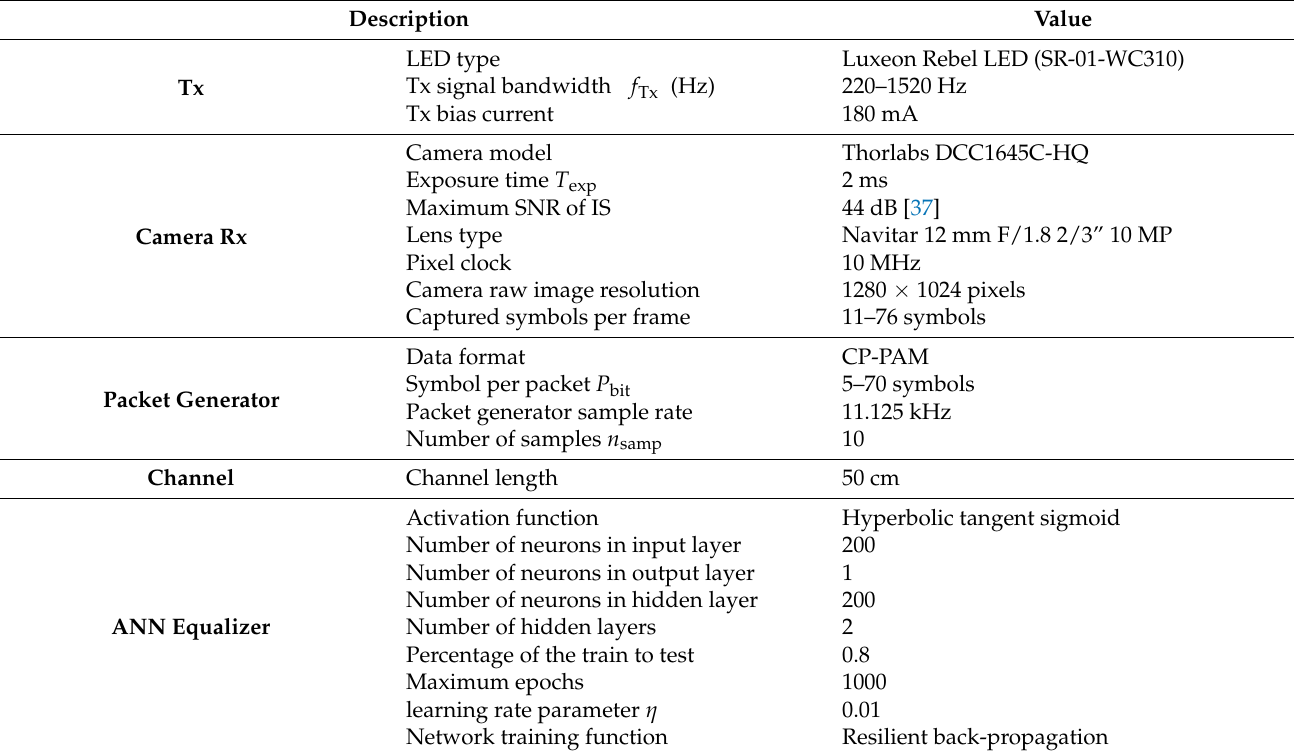
Table 2. System parameters.